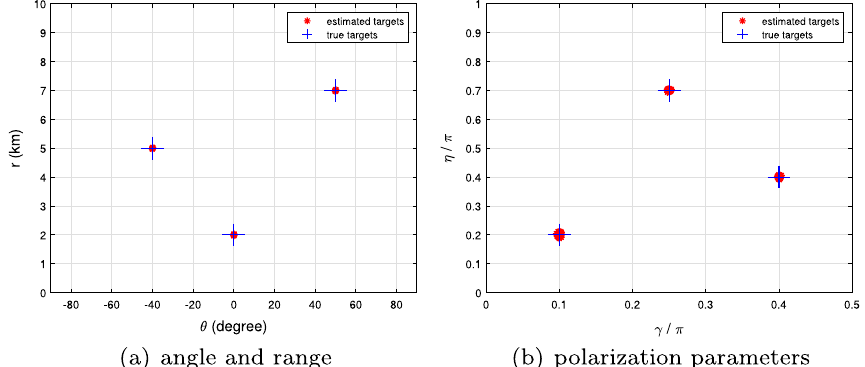
Fig. 4 The range, angle and polarization estimation results using TSS algorithm. M = 8 , N = 8 , P = 3 , L = 100 , SNR 10 dB, (θ , r ) = ( − 40 ◦ ,5km )( 0 ◦ ,2,km )( 50 ◦ ,7km ) , (γ , η) = (π/ 10, π/ 5 )( 2 π/ 5,2 π/ 5 )(π/ 4,7 π/ 10